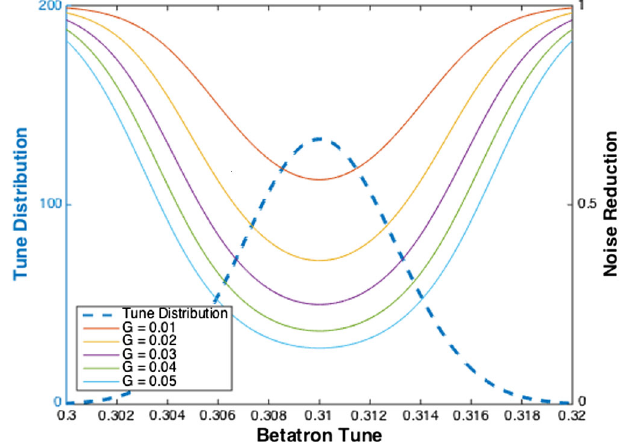
FIG. 7. Noise PSD reduction versus tune for a Gaussian tune distribution ( σ ν ¼ 0 . b